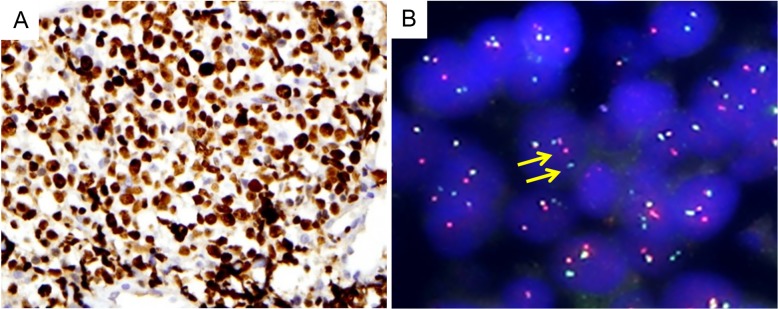
Representative case showing MYC overexpression and rearrangement.High expression of MYC protein (A) and presence of MYC gene rearrangement examined by FISH for MYC, break apart probe (B, split signals indicated by arrows).